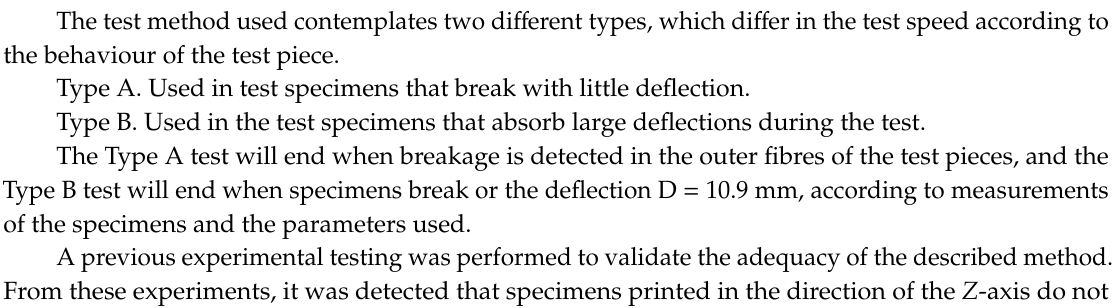
Figure 6. The installation used to perform the four-point bending tests.